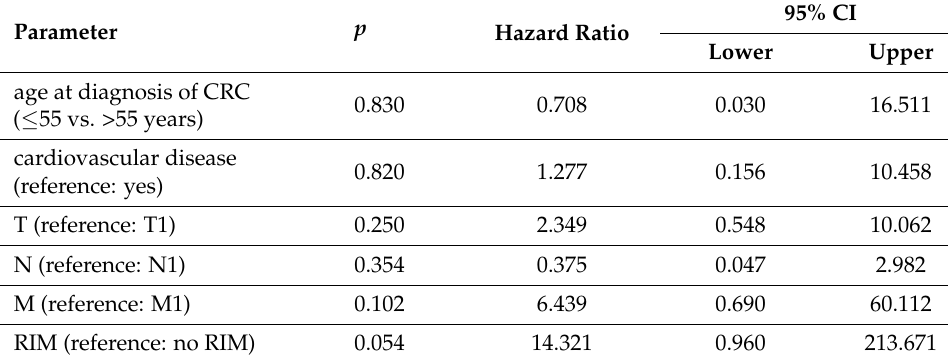
Table 2. Multivariate Regression analysis on impact of survival after diagnosis of CRC after LT.